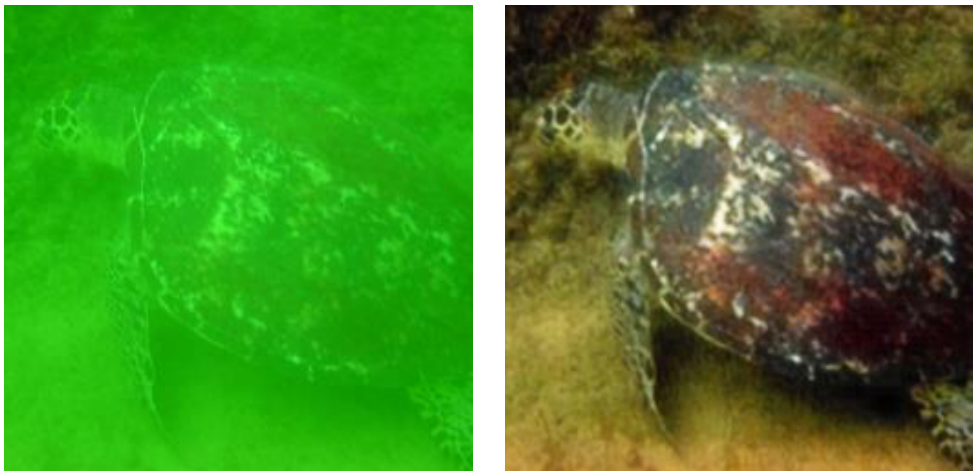
Figure 1. An example of underwater image enhancement result using the proposed method. ( left ): turbid input. ( right ): enhanced